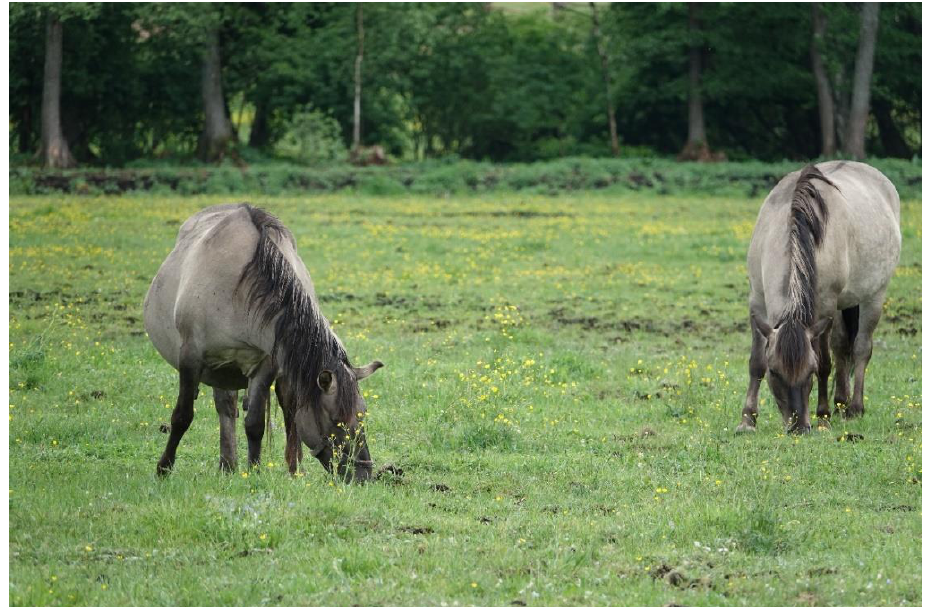
Figure 1. Polish Konik (photo by Izabela Dojlida).